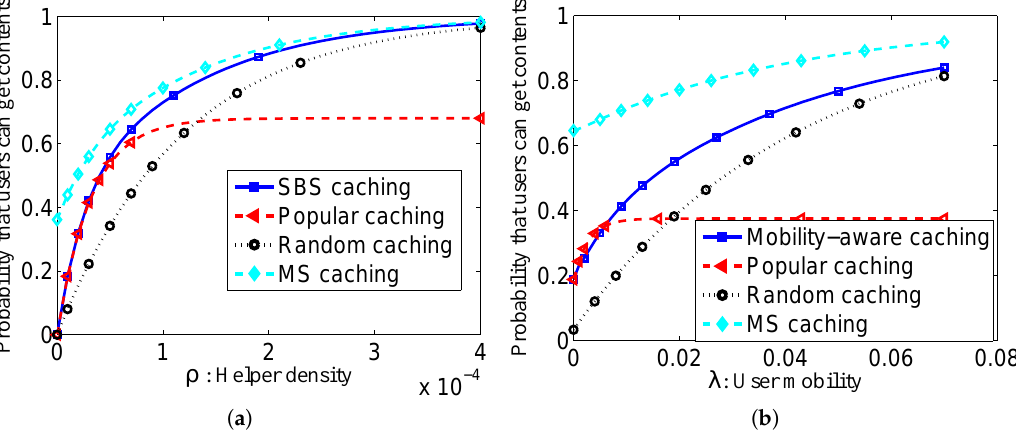
Figure 2. Illustration of the result of caching placement. ( a ) The impact of ρ on the probability that users can get content; ( b ) the impact of λ on the probability that users can get